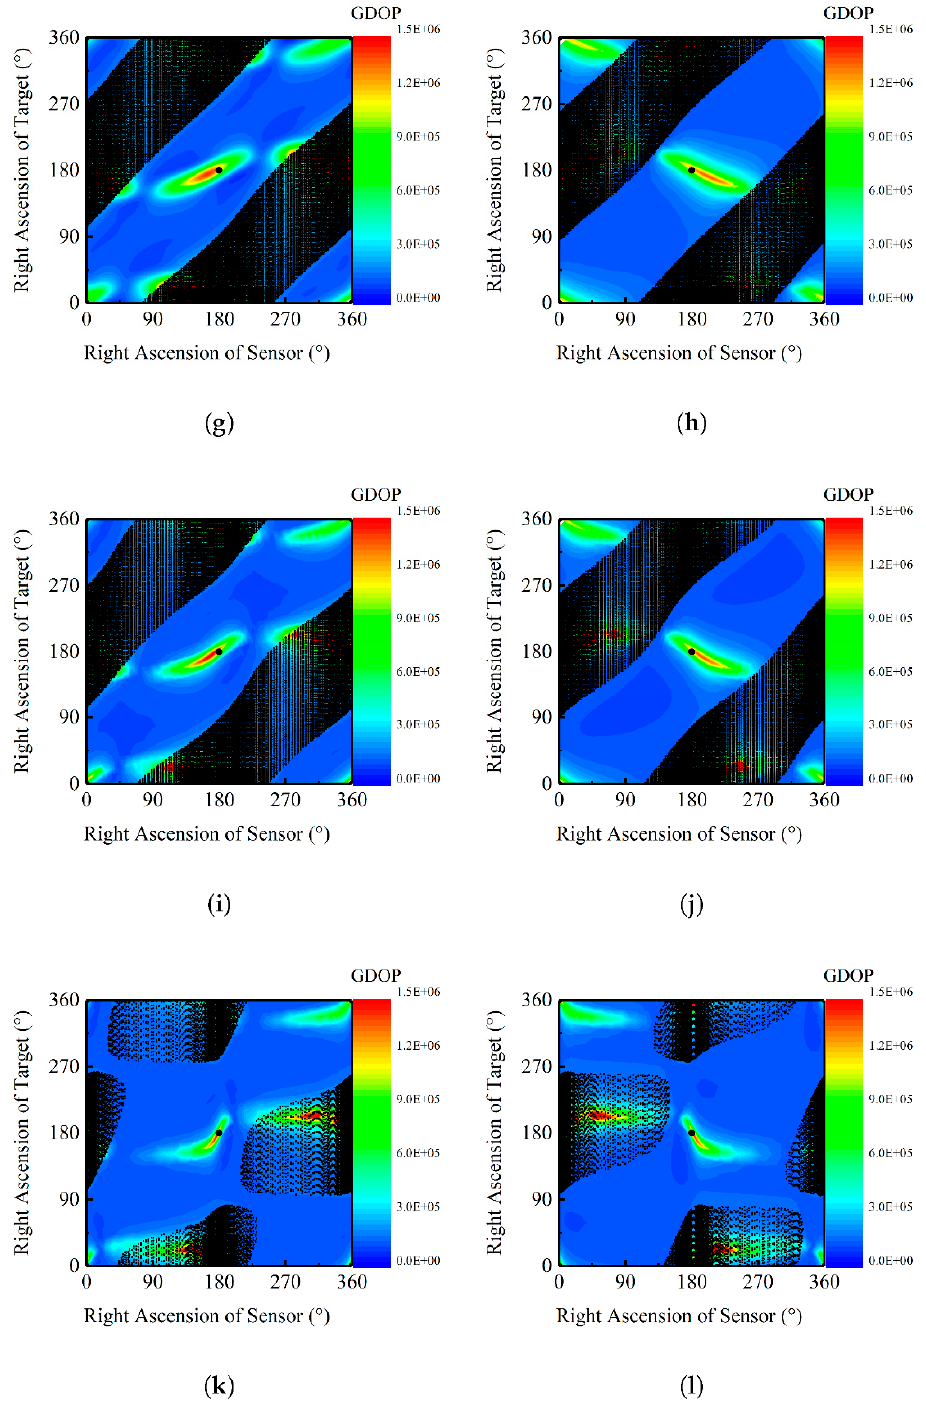
Figure 4. Variations in the GDOP with the observation geometry for different i values: ( a ) 0°, ( b ) 180°, The shaded area in Figure 4 indicates regions that are not visible. The simulation results are consistent with the conclusion that the initial orbit determination accuracy is poor when the target and optical sensor orbit planes are coplanar. The variation characteristics of GDOP with the right ascension of the target and the optical sensor are similar when the angles between the orbital planes of the target and the optical sensor are the same. However, owing to the different directions of the target and optical sensor motion, there are